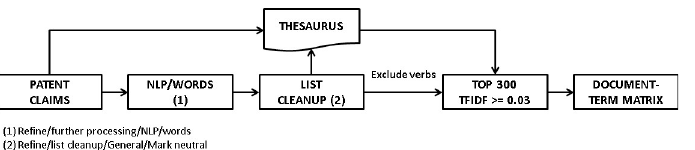
Fig 7. Text mining process. Diagram showing the text-mining steps leading to obtaining the document-term matrices. This process is replicated for each time interval.